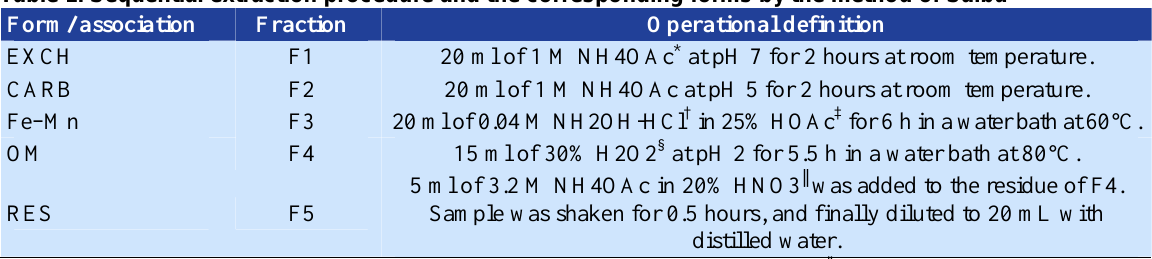
Table 1. Sequential extraction procedure and the corresponding forms by the method of Salbu Form/ association Fraction